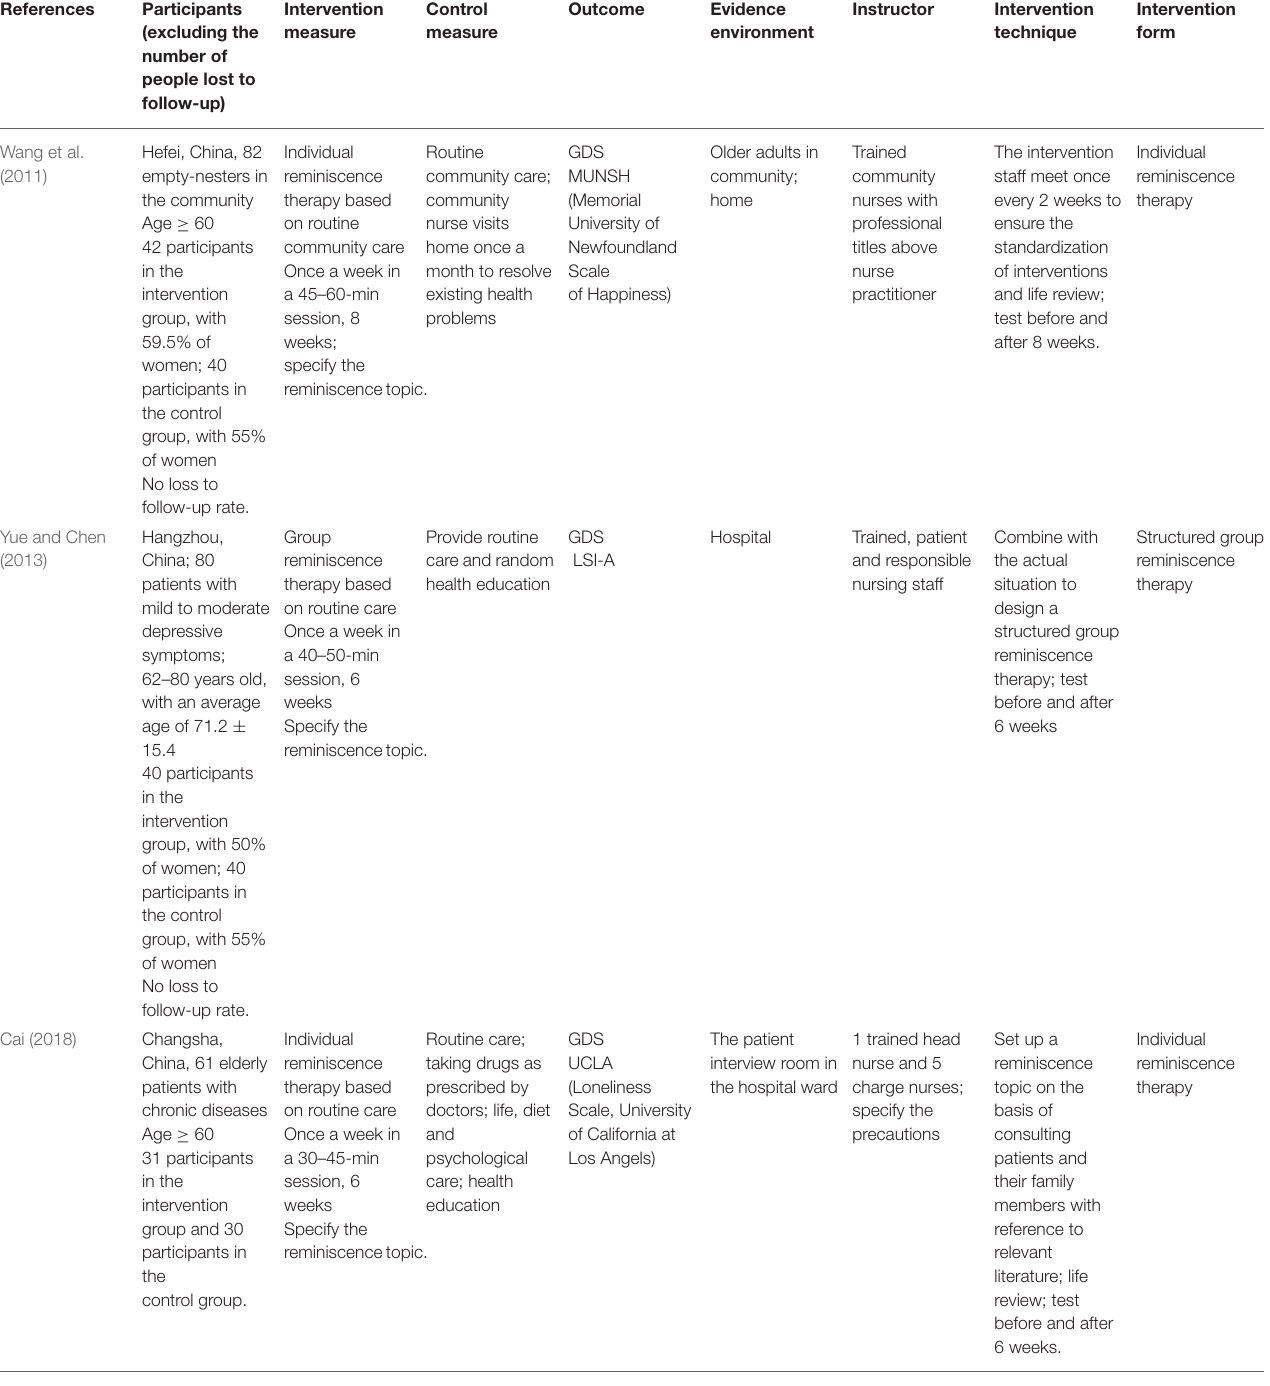
TABLE 1 | The characteristics of the included studies based on the PICOSS